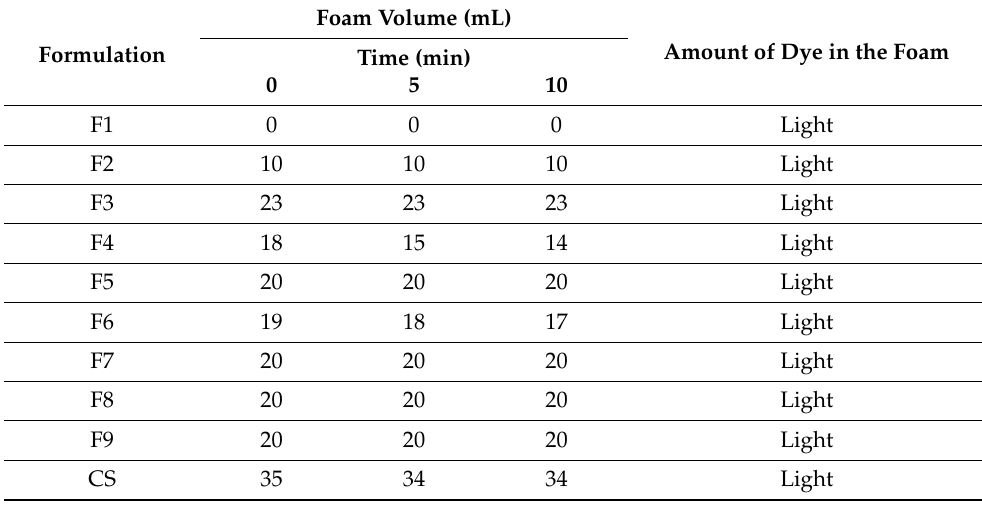
Table 9. Foam stability and dirt dispersion of formulations. The codes of formulations are given in Table 7.